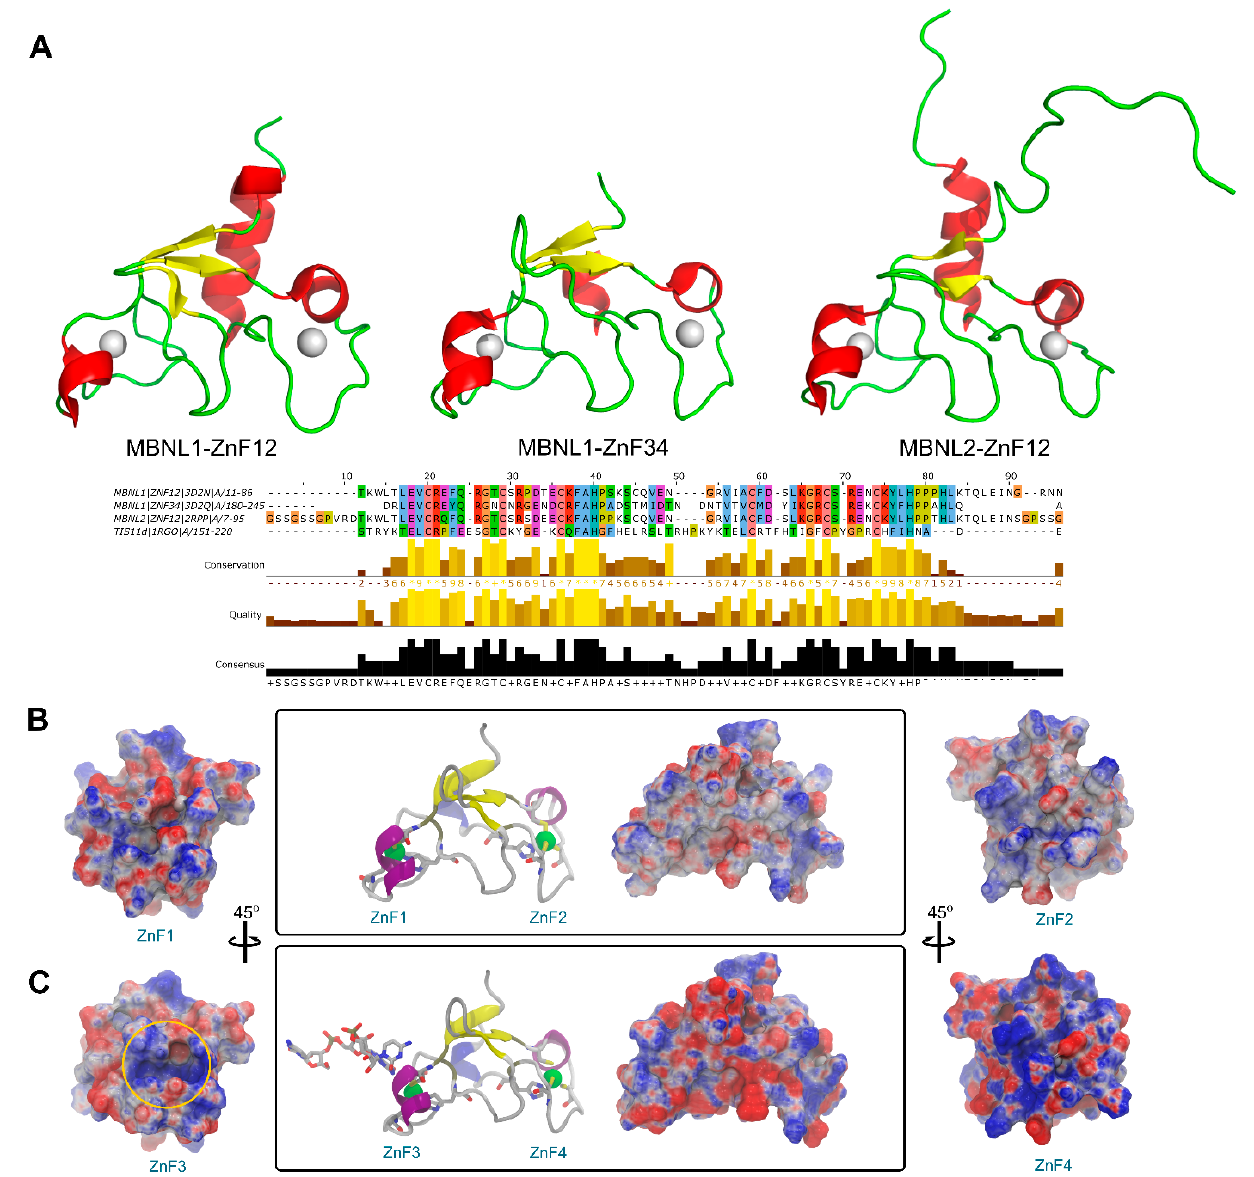
Figure 2. Sequence and structure comparison of MBNL1 ZnFs and MBNL2 ZnF1/2 domains. ( A ) Three-dimensional structure of MBNL1 ZnF1/2, MBNL1 ZnF3/4, and MBNL2 ZnF1/2, including sequence alignment, conservation, quality, and consensus sequence. ( B ) Electrostatic potential surface representation obtained using APBS contoured at ± 10 kT/e for ZnF1/2 (PDB id 3D2N). ( C ) ZnF3/4 of MBNL1 binding an RNA fragment (PDB id 3D2S). The ZnF3 binding site region is contoured with a yellow circle.